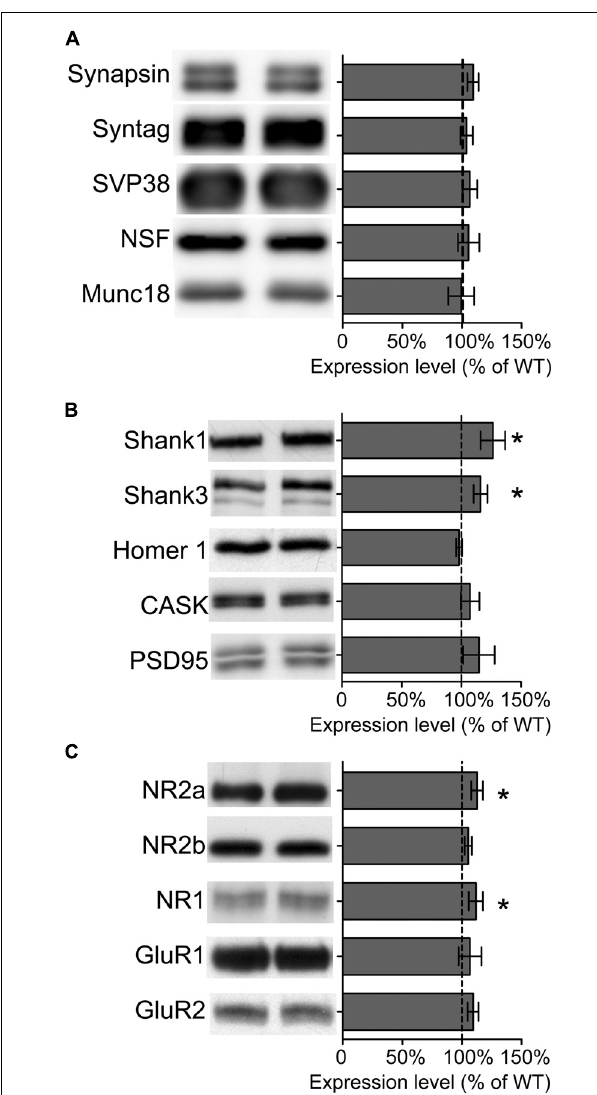
FIGURE 4 | Expression of some synaptic proteins are altered in Sarm1 knockdown mice. (A) Presynaptic proteins. (B) Post-synaptic protein. (C) Glutamate receptors.The synaptosomal fractions of the hippocampi were analyzed by immunoblotting with antibodies, as indicated. Five animals for each genetic background were used for analysis.The data represent the mean ± SEM normalized to theWT levels. * P < 0.05. glutamate treatment in vitro as well as enhanced NMDAR- dependent LTP and impaired mGluR-dependent LTD in hip- pocampi. The behavioral rescue by CDPPB, a positive allosteric modulator of mGluR, further supports a role for mGluR signal- ing in the pathogenesis of autistic-like behaviors that are caused by Sarm1 knockdown. Metobotrophic GluR signaling activity is known to mediate spine shrinkage and degradation (Oh et al.,